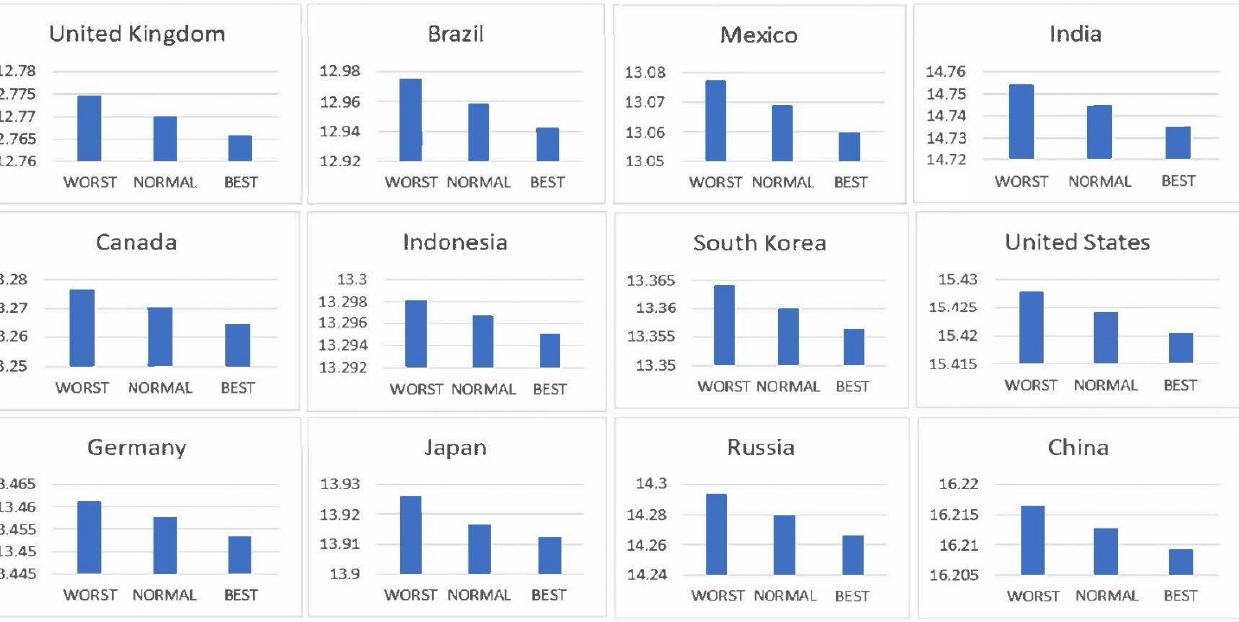
Figure A1. CO 2 emissions of countries with increased emissions under the three scenarios.